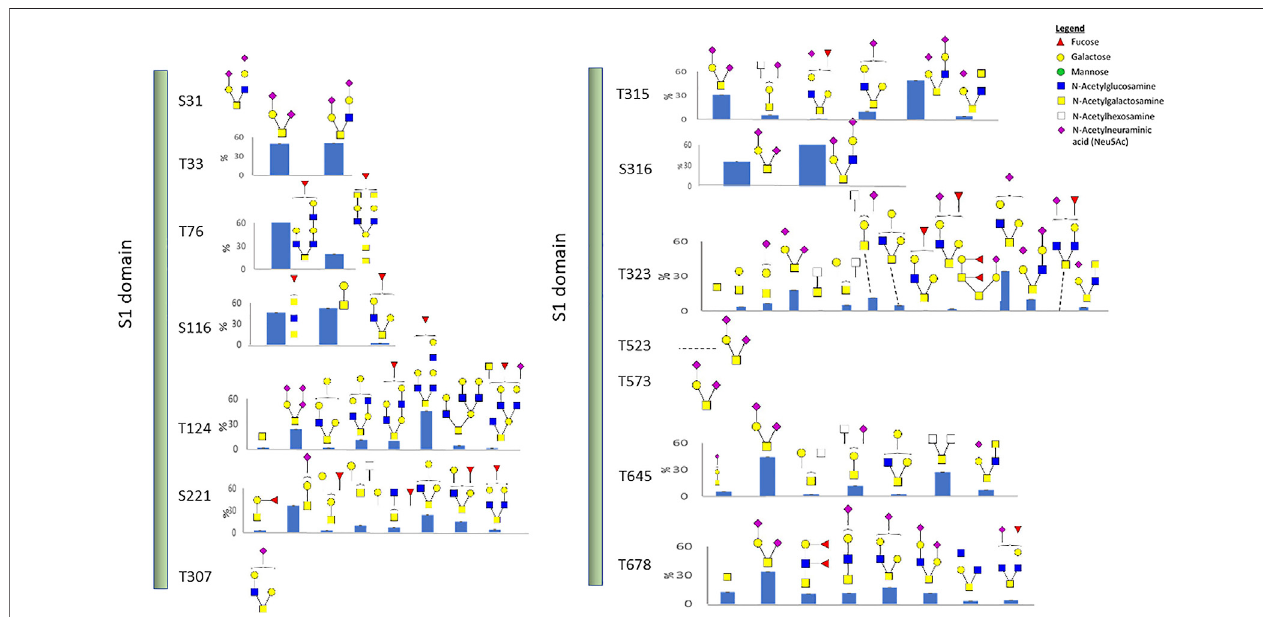
FIGURE3 | O-linked glycosylation ofthe recombinantS1 protein. Glycancartoonstructuresare inferred from knowledge ofcommon glycansasidenti fi cation was solely based on mass.